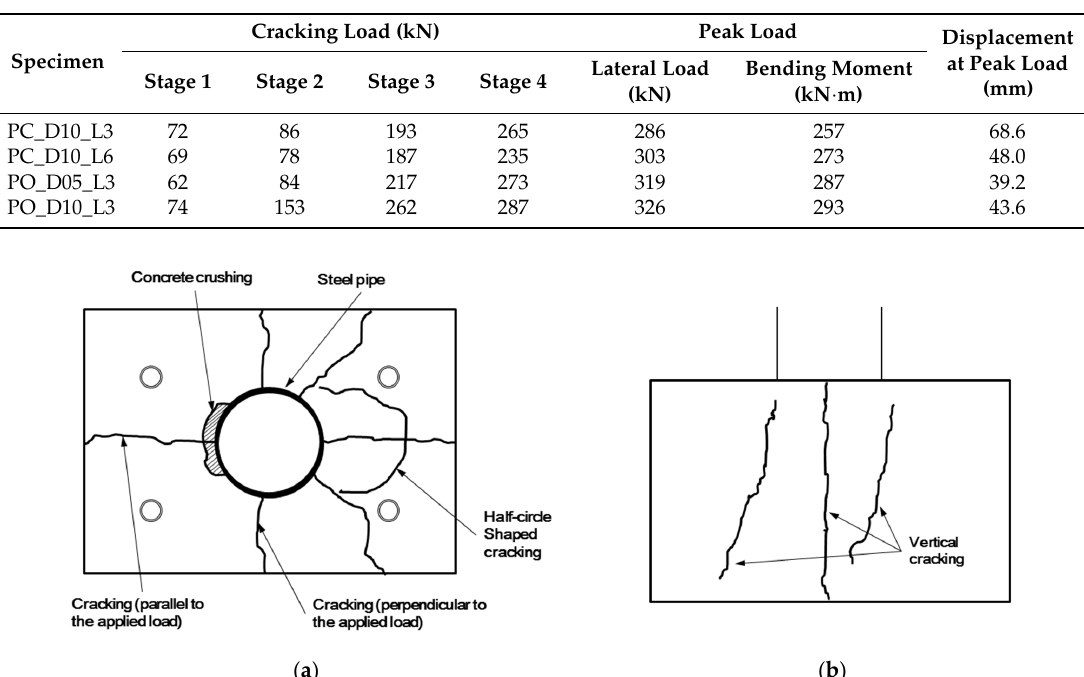
Figure 6. Typical cracking patterns of test specimens. ( a ) Top surface of the concrete block. ( b ) Side surface of the concrete block.